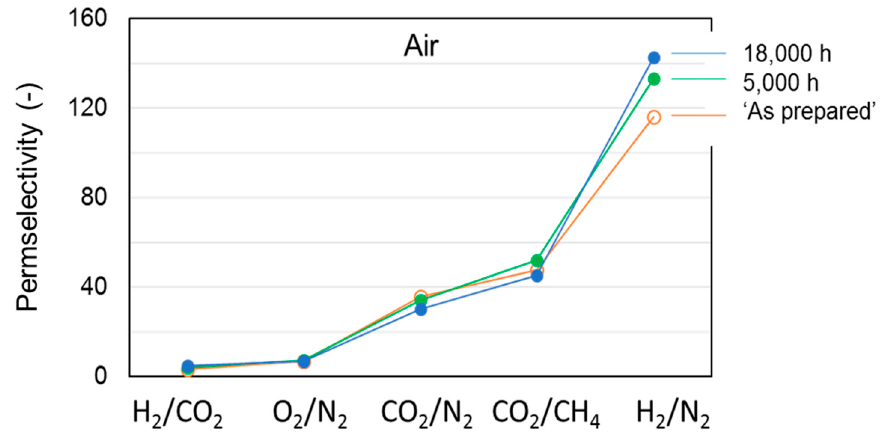
Figure 6. Effect of aging on permselectivity for different gas pairs in cross-linked HF membranes (T3- a).